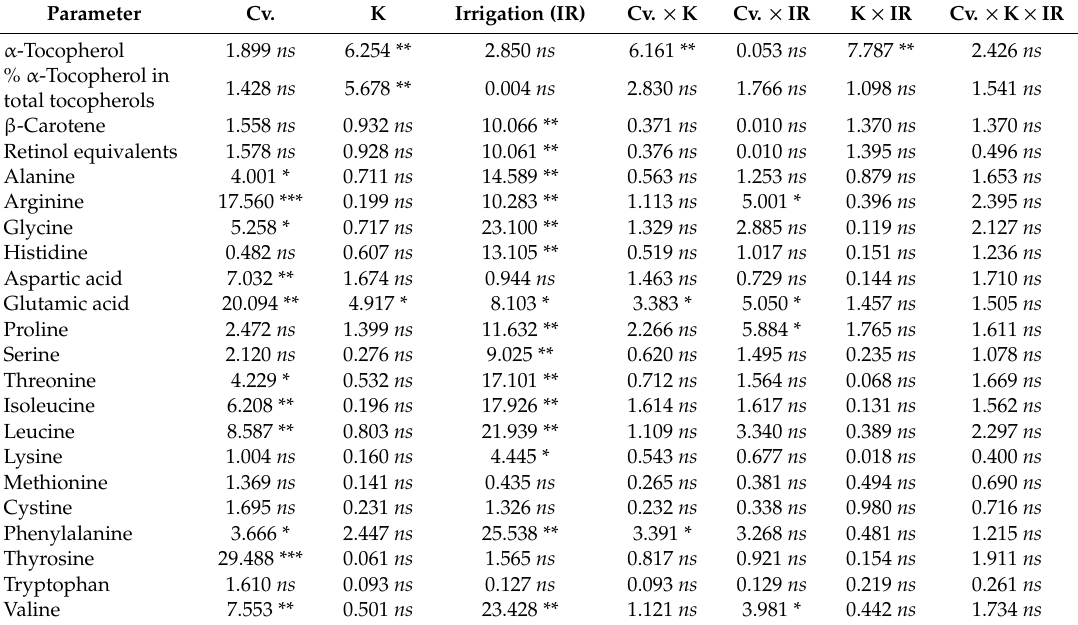
Table 1. F -test statistics in